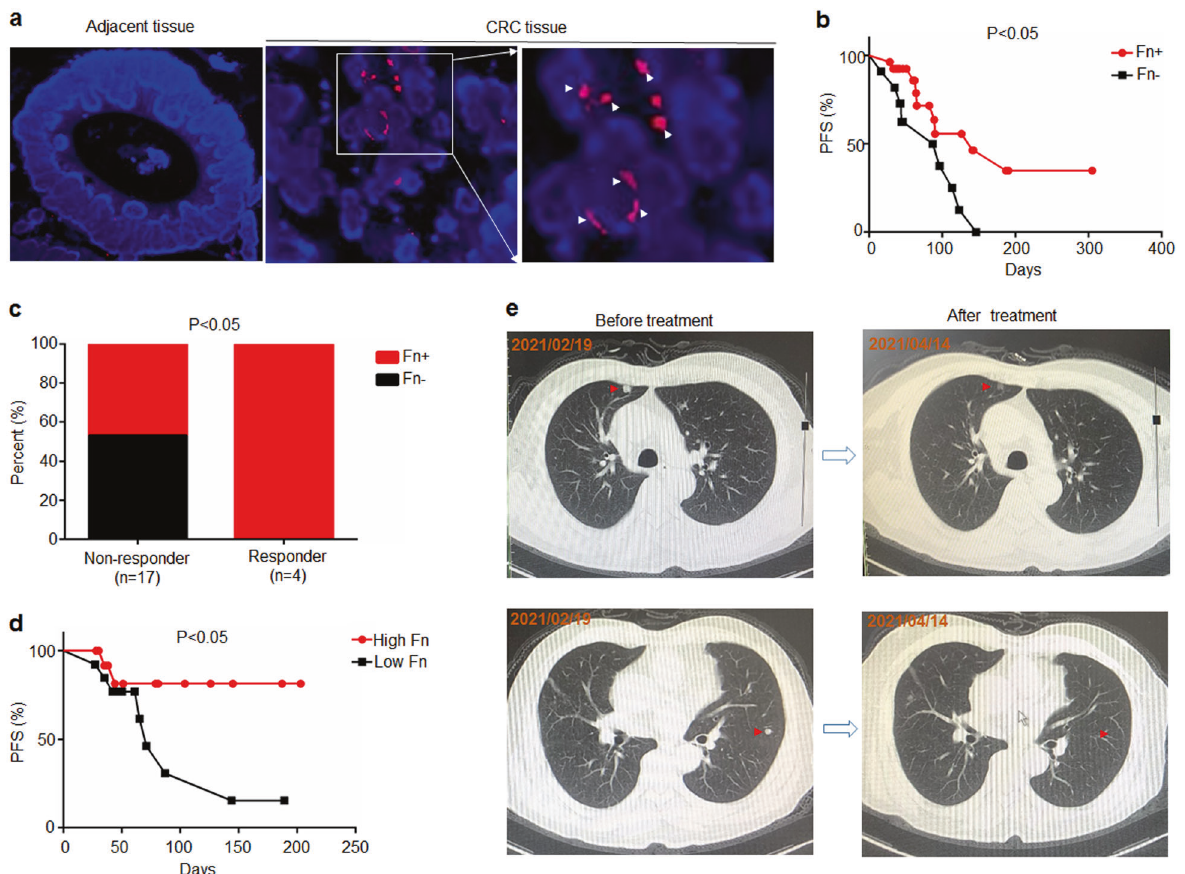
The progression-free survival of patients with CRC ( n = 38) strati fi ed by their F. nucleatum levels in tumor tissues. Fn + and Fn – represent the patients with F. nucleatum -positive and negative tumor tissues, respectively. Log-rank test. c Correlation analysis between patient outcomes and F. nucleatum levels in CRC tumor tissues ( n = 24). Patients showing no sign of progression within 6 months after PD-1 blockade treatment were de fi ned as responders, while those who progressed within 6 months after PD-1 blockade treatment were de fi ned as non-responder. Chi-square test (one-sided). d The progression-free survival of patients with CRC ( n = 27). The F. nucleatum levels in feces were measured by RT-PCR. Patients were divided into high F. nucleatum groups and low F. nucleatum groups according to the median. Log-rank test. e Representative CT images of a patient with lung metastasis before and after treatment of PD-1 blockade. The red arrows indicate lung metastases nucleatum were more responsive to PD-1 blockade than those with low levels of F.